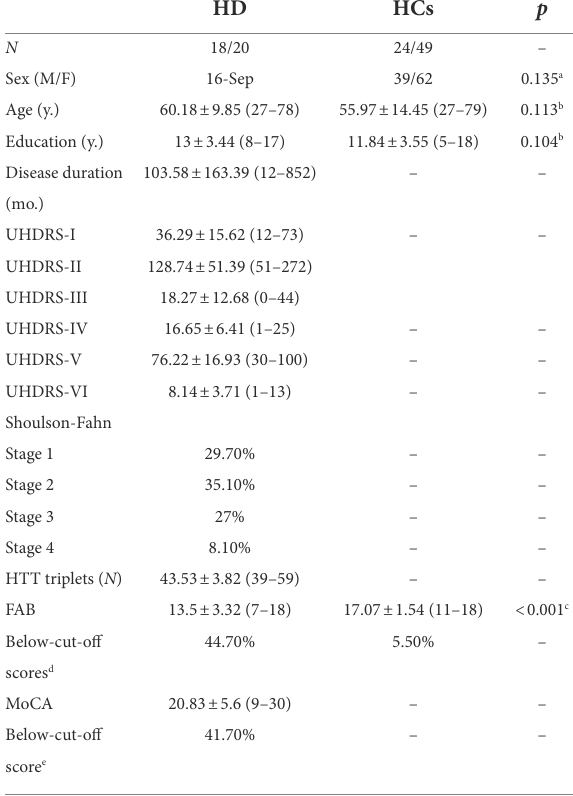
TABLE 1 Participants’ demographic and clinical